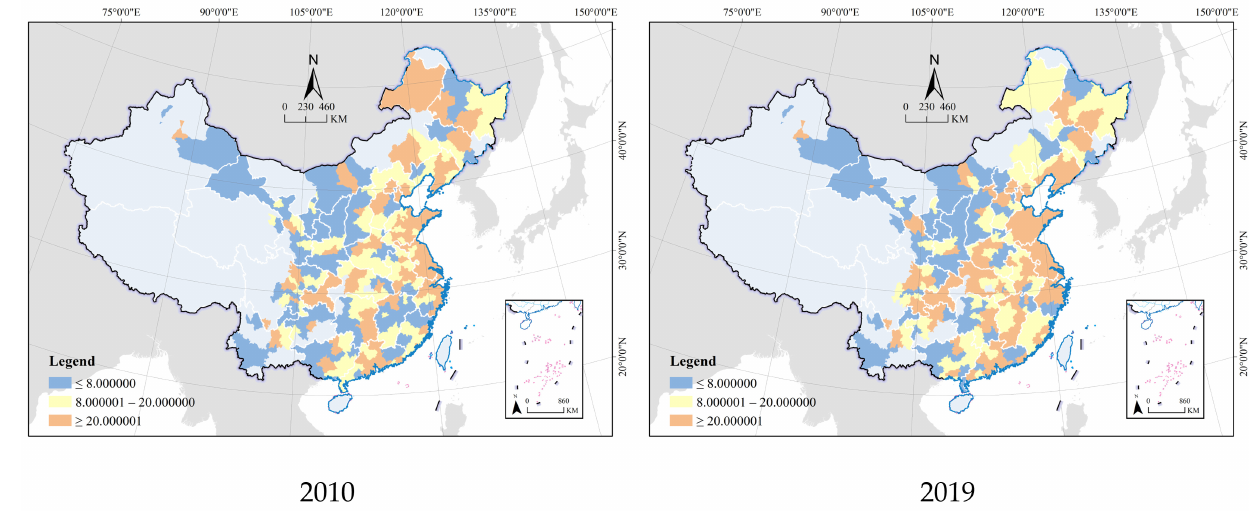
Figure 4. Distribution of industrial land scale.